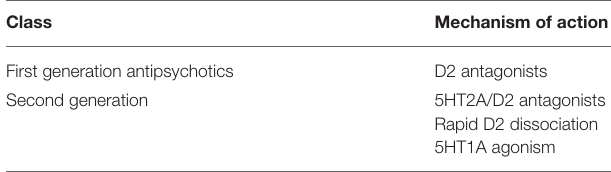
TABLE 1 | Basic mechanism of action of